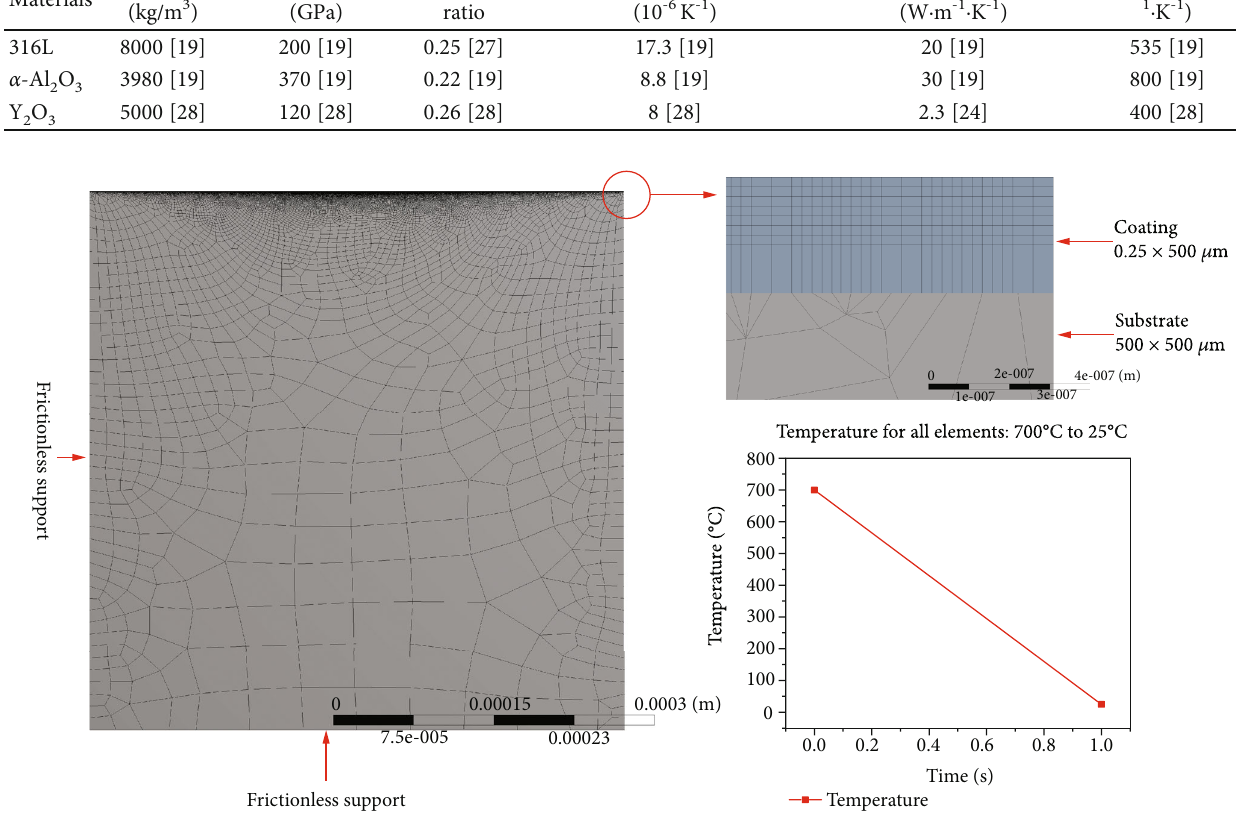
Figure 3: Mesh and boundary condition of the fi nite element ( t = 250nm